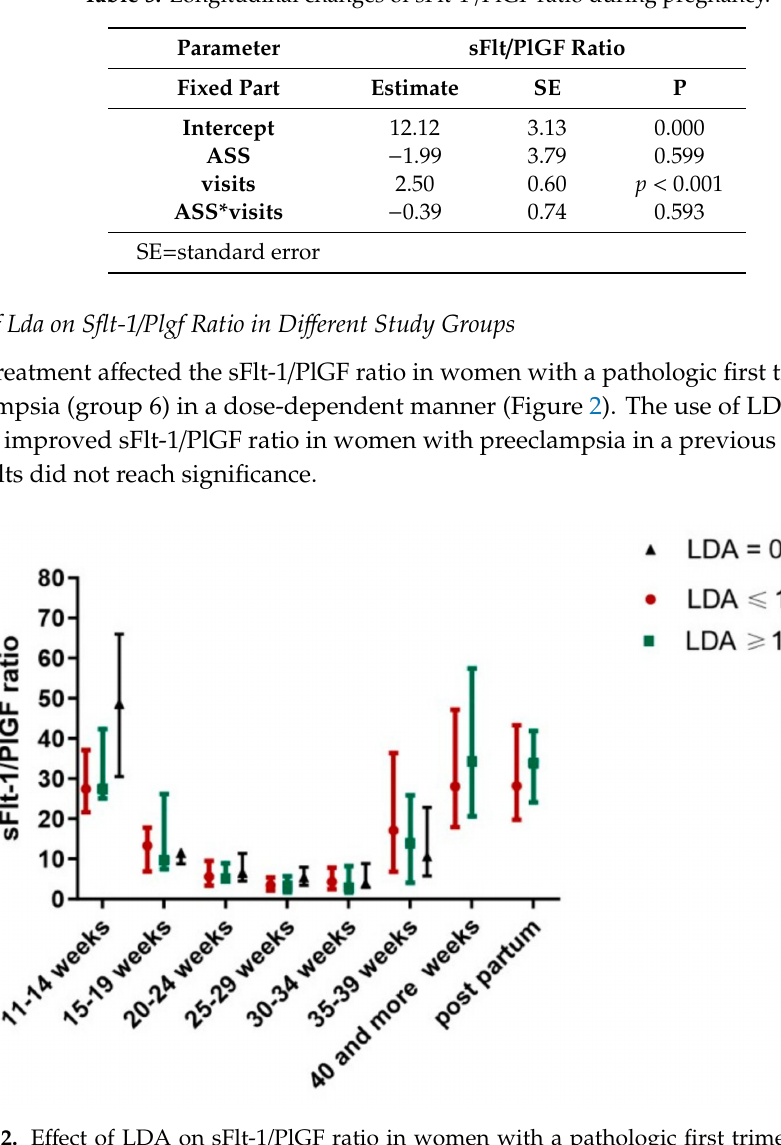
Figure 2. E ff ect of LDA on sFlt-1 / PlGF ratio in women with a pathologic first trimester screening for